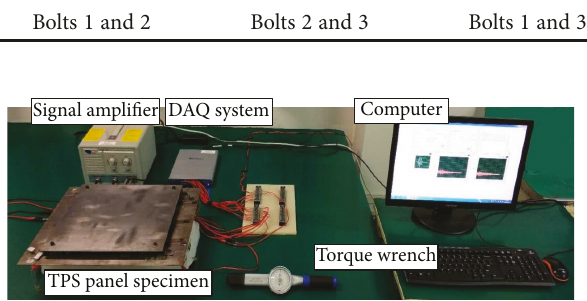
Figure 5: The experimental platform.